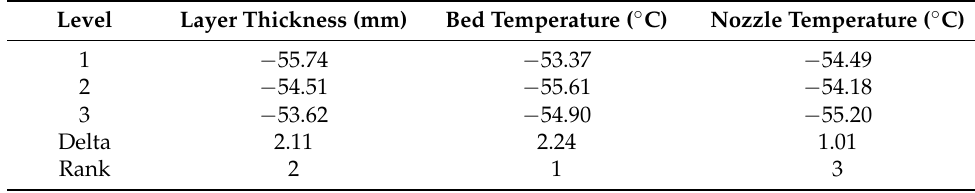
Table 6. S/N ratios response table for experimental H.